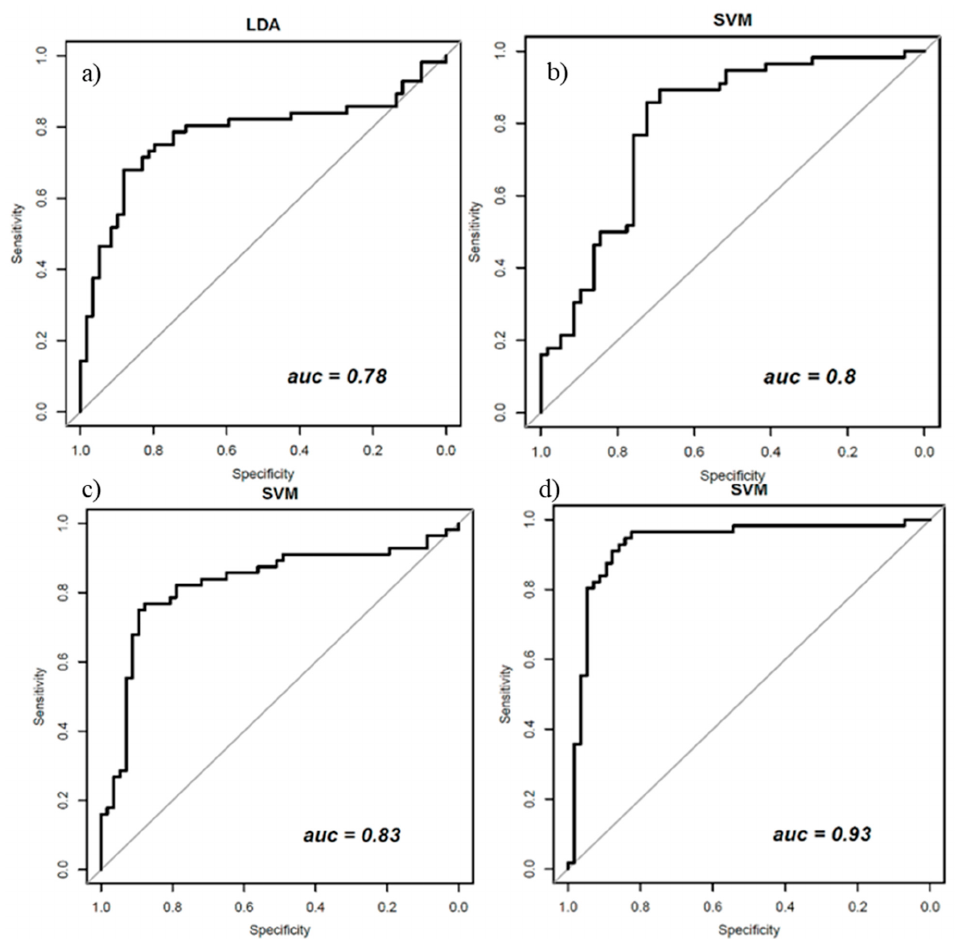
Figure 4. ROC curve of the best classifiers in ( a ) an LDA (linear discrimination analysis) using the all-balanced textural features set; in ( b ) a SVM using a subset of five robust morphological features (circularity, rectangularity, sphericity, gleaning and surface); in ( c ) an SVM using the all-balanced dynamic features set; in ( d ) an SVM with a subset of 37 robust textural, morphological and dynamic features.